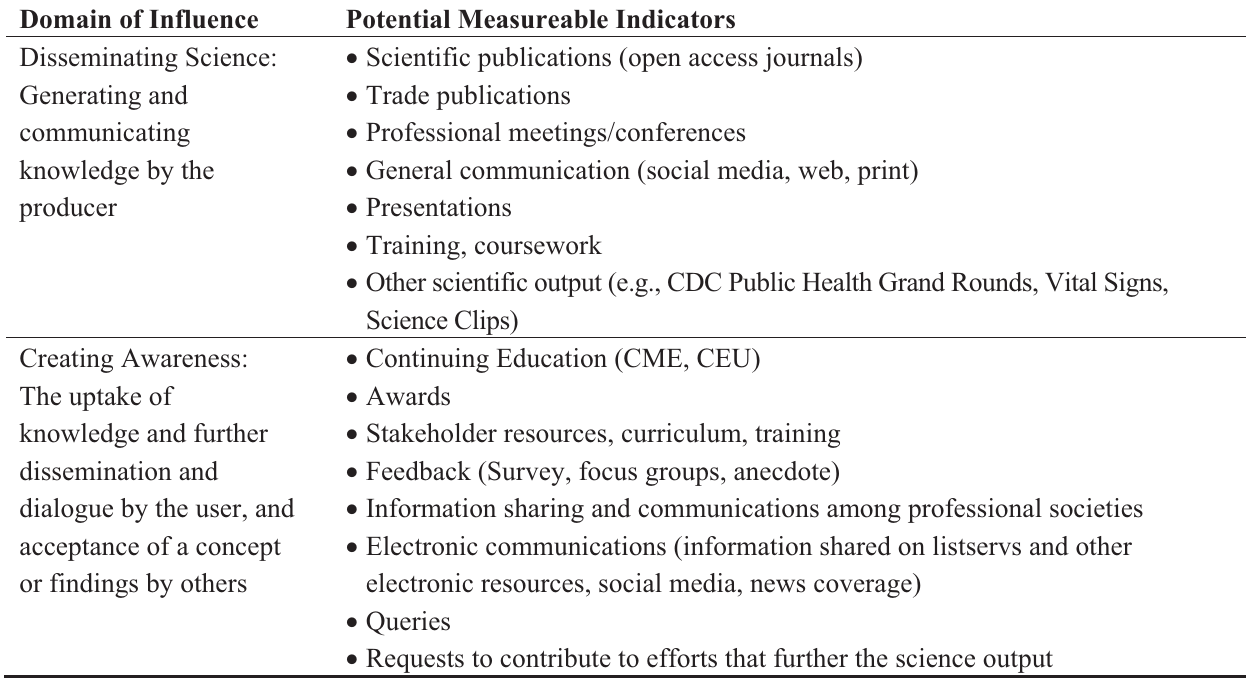
Figure 1. The science impact framework [18]. Table 2. The domains of influence within the science impact framework and example indicators (modified from